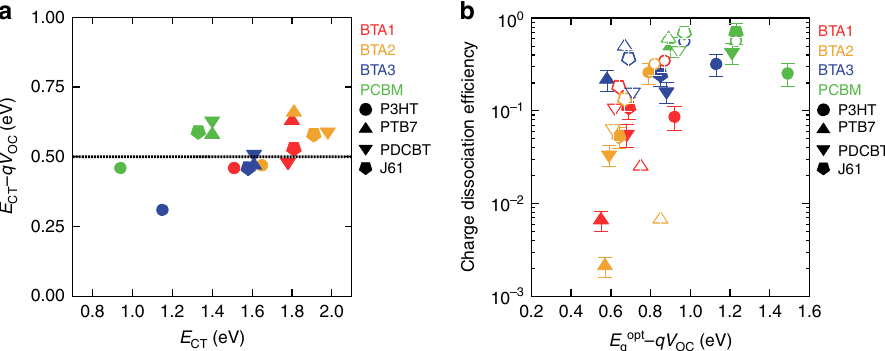
Fig. 7 Energy loss. a E CT − qV OC , the energy loss due to charge recombination plotted against E CT . b Charge generation ef fi ciency plotted against the overall energy loss, E g opt − qV OC . The error bar indicates the variation of the assumed exciton collection length NATURE COMMUNICATIONS| (2019) 10:2520